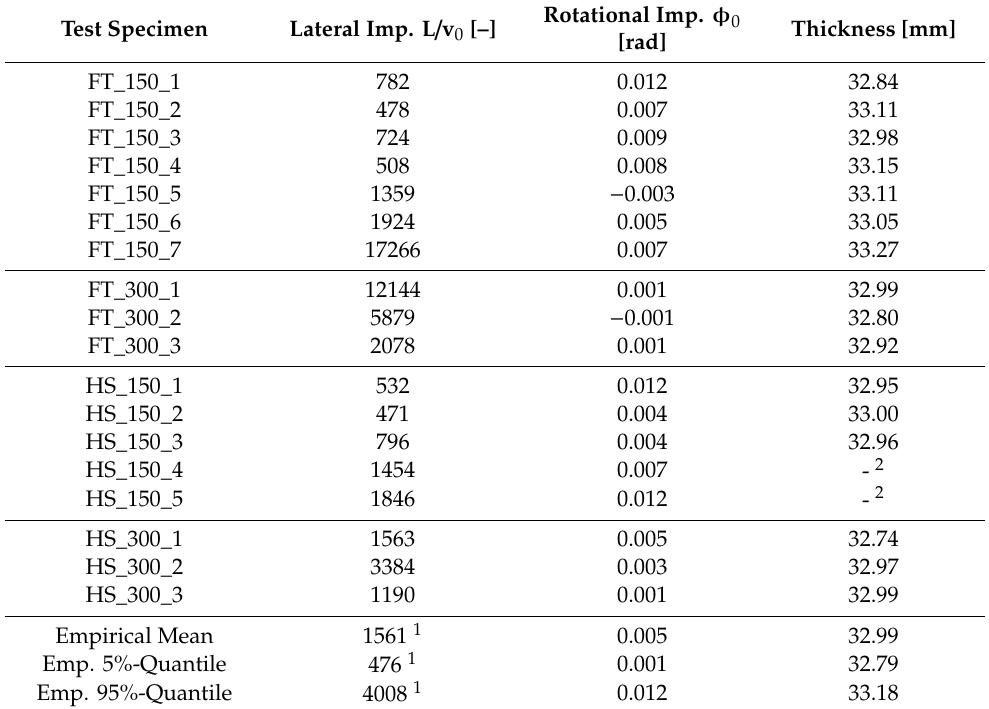
Table 2. Measured lateral and rotational imperfections of all test